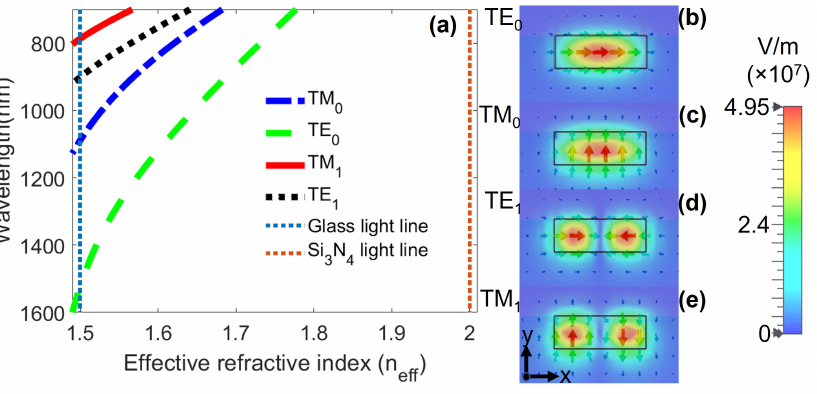
Figure 2. ( a ) Dispersion curves of the Si 3 N 4 waveguide. The cutoff wavelengths for the fundamental = 1523 nm and λ = 1089 nm, respectively. The TE TE 0 and TM 0 modes are λ TE TM 0 c 1 mode has a 0 c = 901 nm and for the TM1 mode λ = 787 nm. ( b – e ) Intensity maps and cutoff wavelength λ TE TM 1 c 1 c electric field distribution for the modes at n ef f =